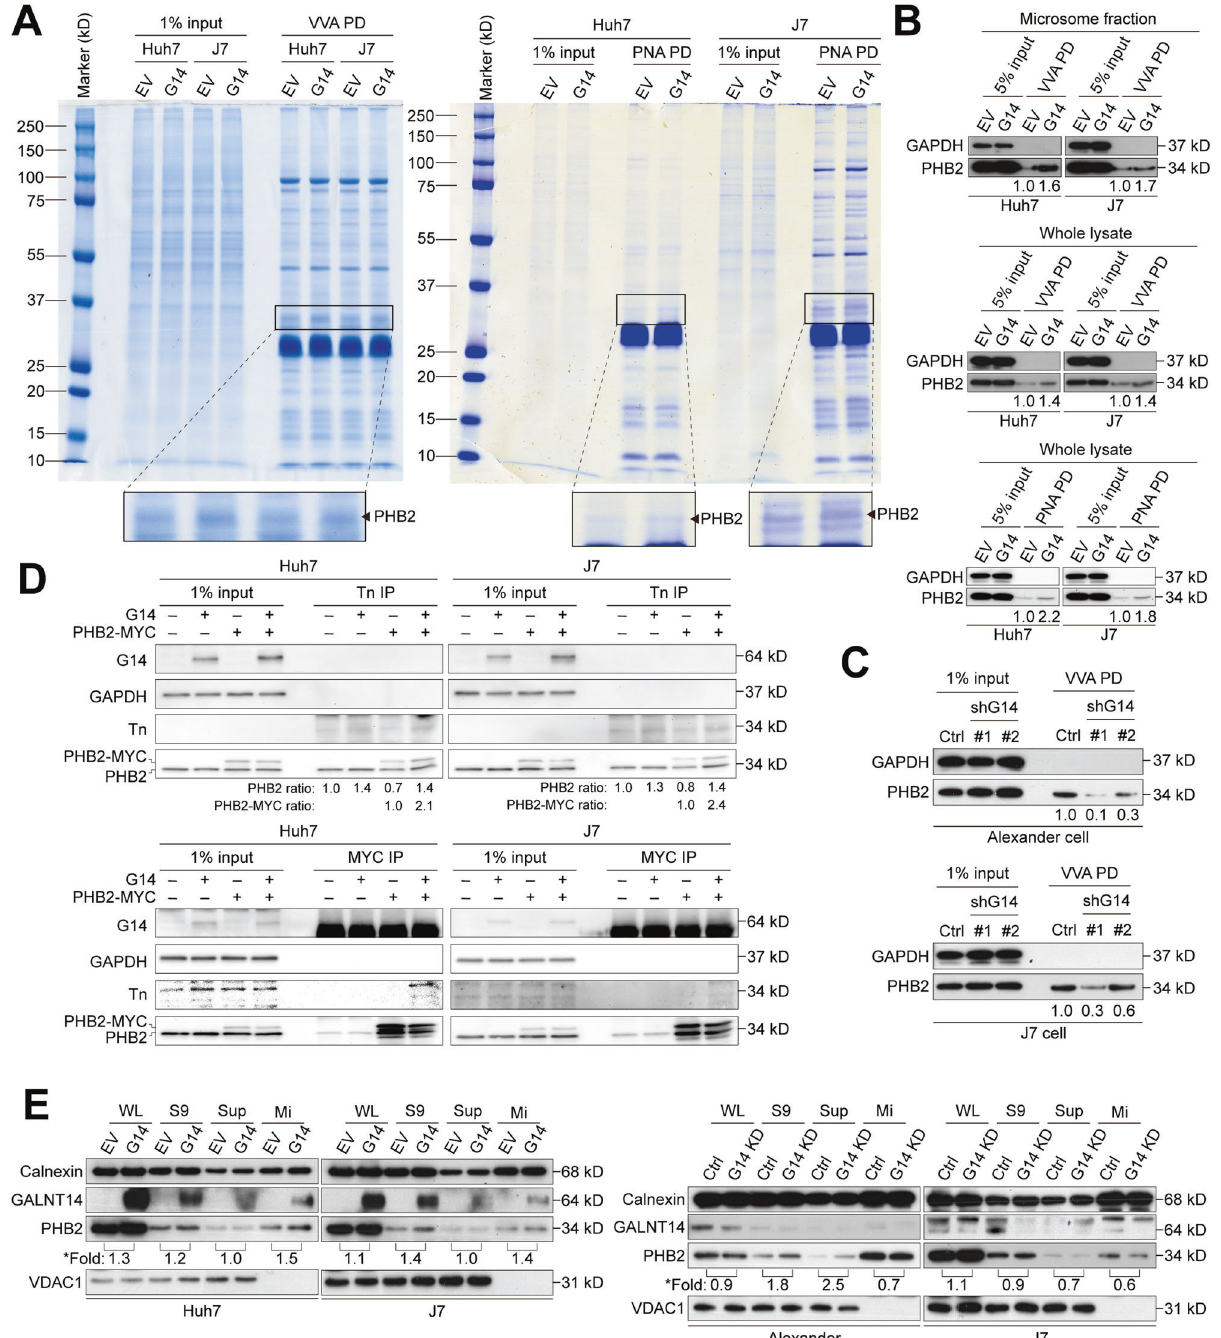
Fig. 3 PHB2 is a promising GALNT14 substrate. A Microsomal fractions isolated from Huh7 and J7 cells were subjected to Vicia villosa (VVA)- or peanut agglutinin (PNA)-mediated pulldown (PD). Pulldown proteins were separated by 10% SDS-PAGE and stained by the colloidal blue silver stain. Protein bands with signi fi cant density changes were excised for LC/MS/MS identi fi cation. B , C Representative western blots demonstrating enriched PHB2 levels by VVA- or PNA-mediated pulldown in HCC cells with or without GALNT14 overexpression or silencing. D Western blotting following Tn antigen or MYC-tag immunoprecipitation (IP) using lysates of HCC cells transfected with the indicated plasmids. E Distribution of PHB2 and GALNT14 in microsomal fractions assessed by western blot using lysates of Huh7 and J7 cells with GALNT14 overexpression (upper) and silencing (lower). Calnexin was used as a speci fi c marker for microsome fraction, while VDAC1 was used as a marker for the mitochondrial fraction. *Fold, fold of increase upon GALN14 (G14)